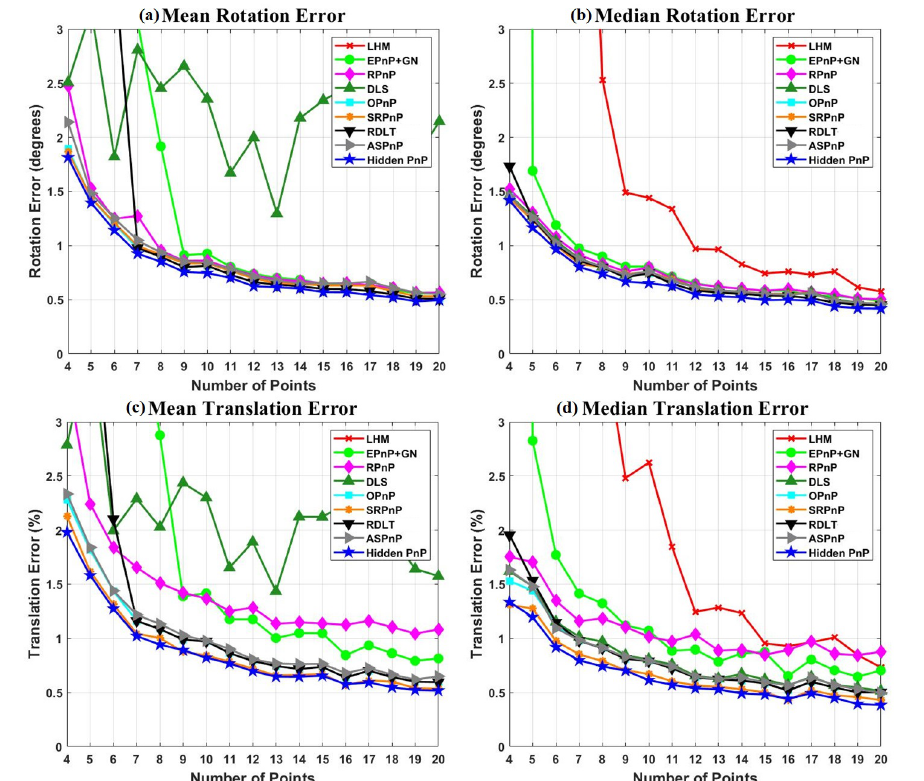
Figure 5. Error comparison in the Quasi-Singular